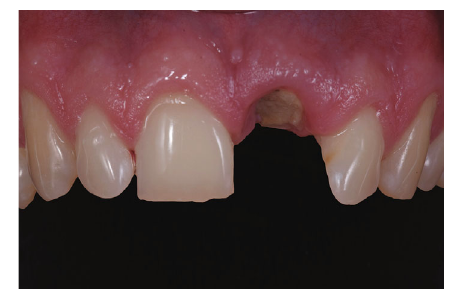
Figure 1: Clinical view of the patient with a root fracture of the upper left central incisor. The root is still in situ.